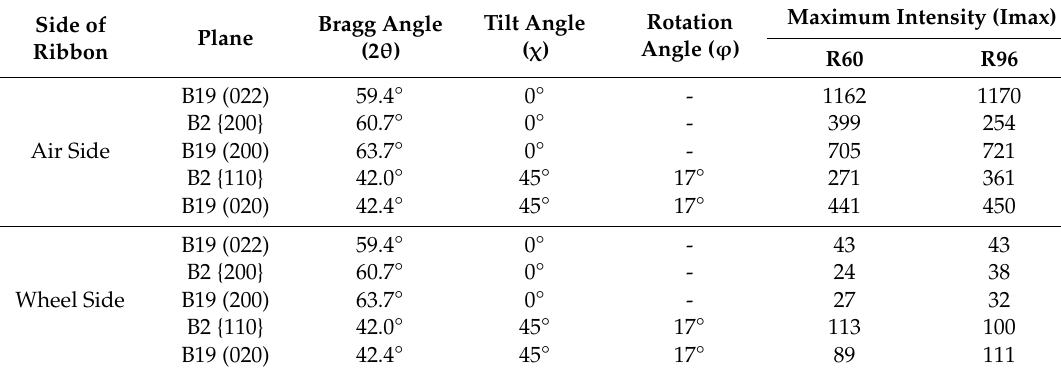
Figure 7. B2 and B19 phase crystal structures.